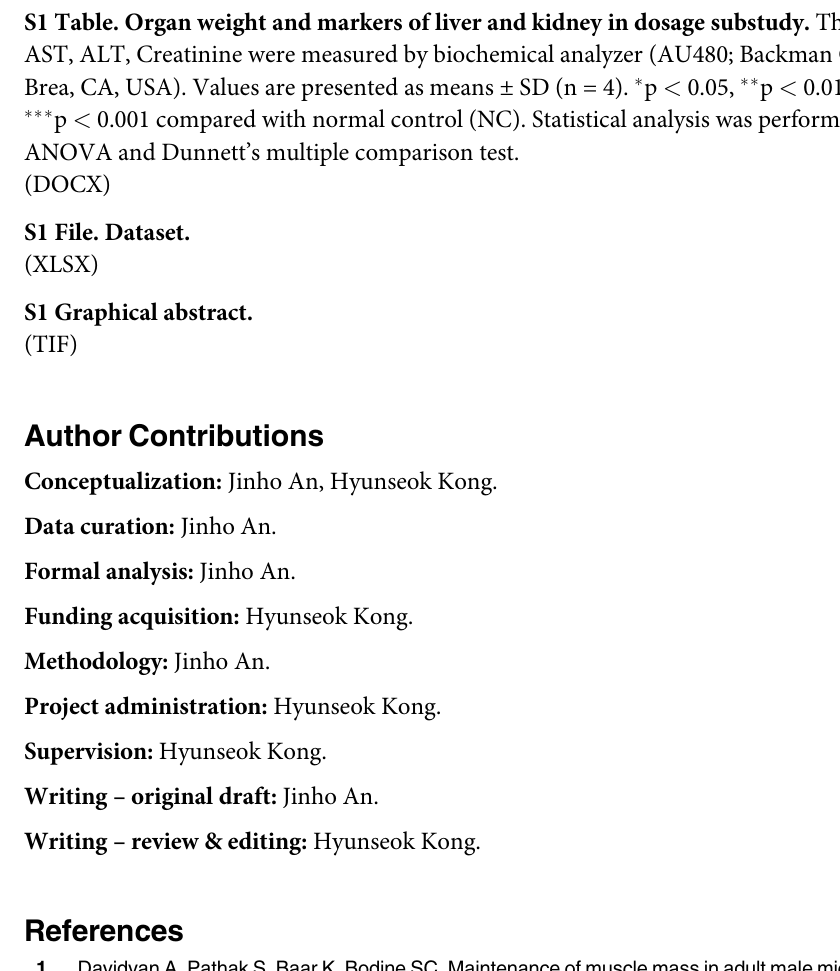
S1 Table. Organ weight and markers of liver and kidney in dosage substudy. The levels of AST, ALT, Creatinine were measured by biochemical analyzer (AU480; Backman Coulter, Brea, CA, USA). Values are presented as means ± SD (n = 4). � p < 0.05, �� p < 0.01, ��� p < 0.001 compared with normal control (NC). Statistical analysis was performed by ANOVA and Dunnett’s multiple comparison